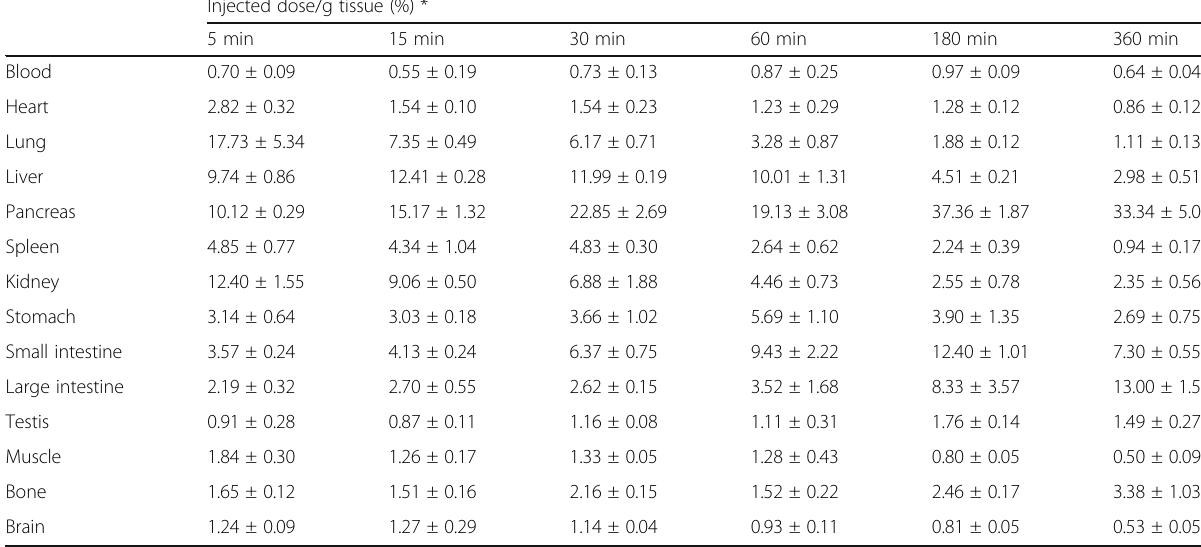
Table 3 Tissue distribution of radioactivity in mice after intravenous injection of [ 18 F]MC225 Injected dose/g tissue (%) *